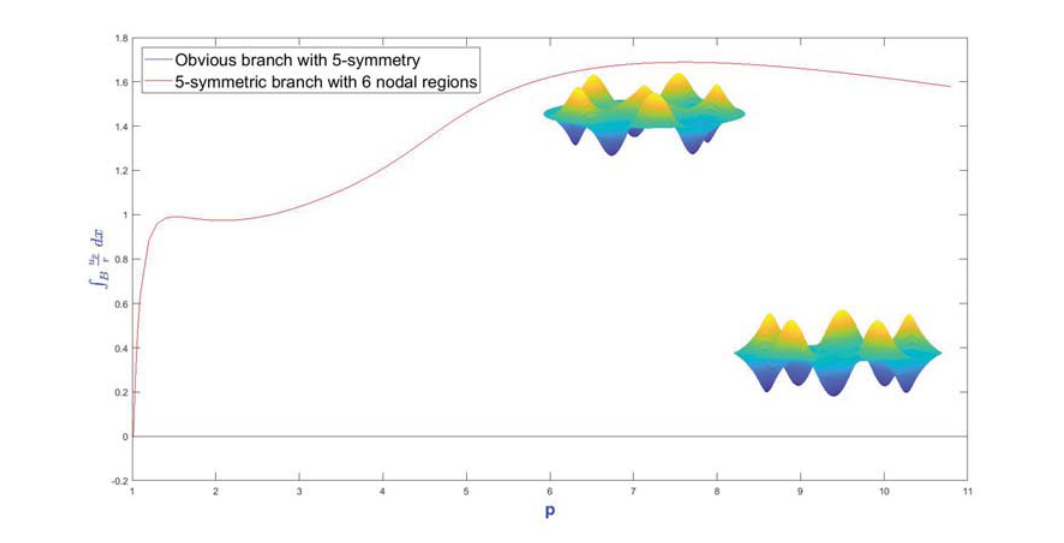
Fig. 13: Bifurcation diagram of the “obvious” numerical solutions with 5-symmetry and the 5-symmetric solutions with 6 nodal